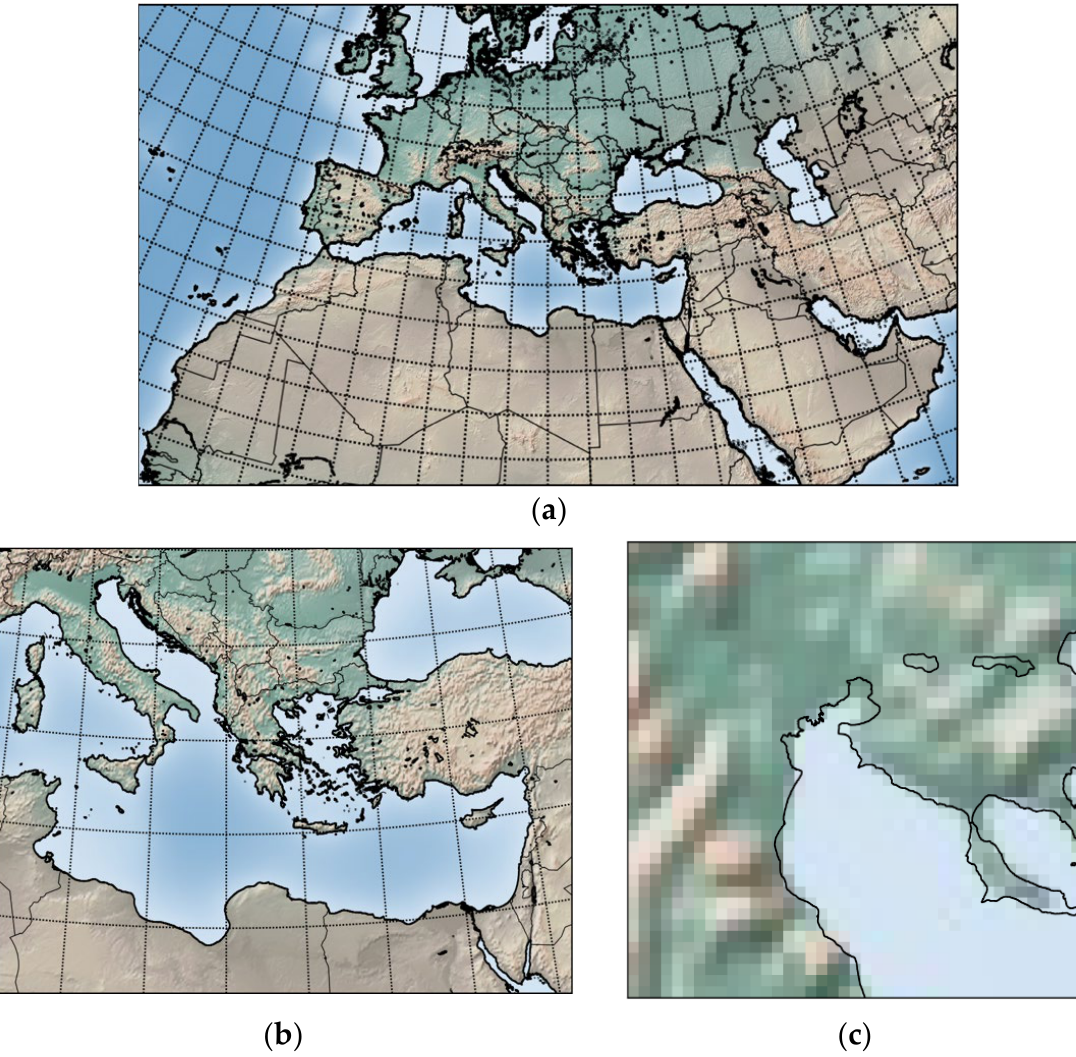
Figure 1. Modeling domains: ( a ) Europe, North Africa and Middle East (18 × 18 km 2 , d01), ( b ) Eastern Mediterranean (6 × 6 km 2 , d02) and ( c ) greater area of Thessaloniki (2 × 2 km 2 , d03).